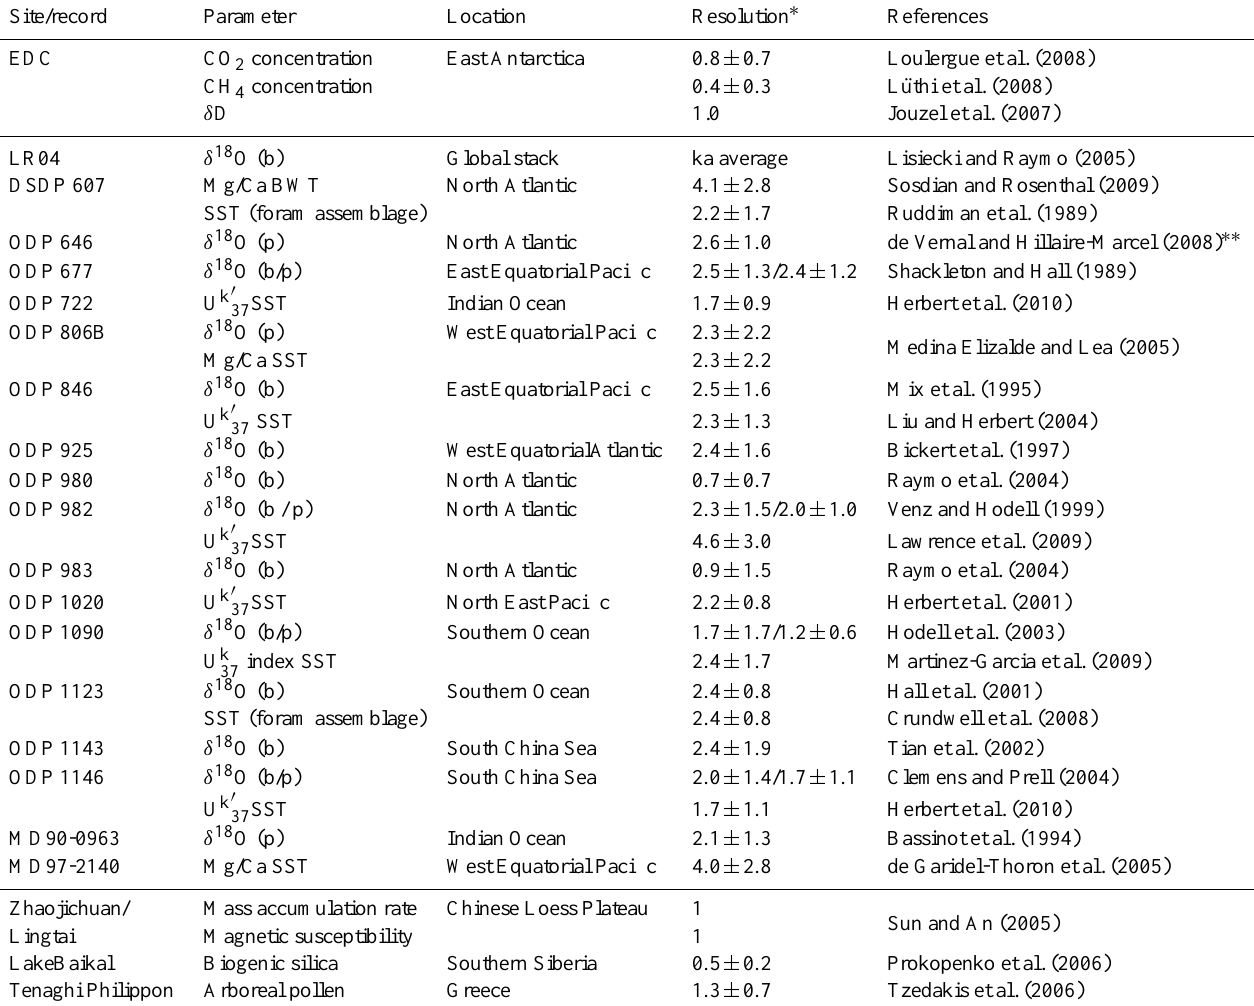
Table 1. Palaeoclimate records included in this